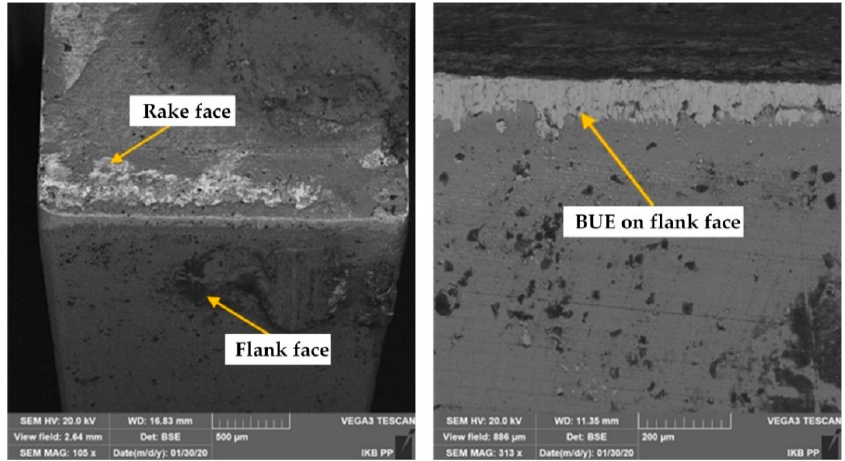
Figure 7. The scanning electron microscope (SEM) images of DDCC inserts after grooving with v c = 800 m/min, f = 0.15 mm/rev, t s ≤ 30 min.